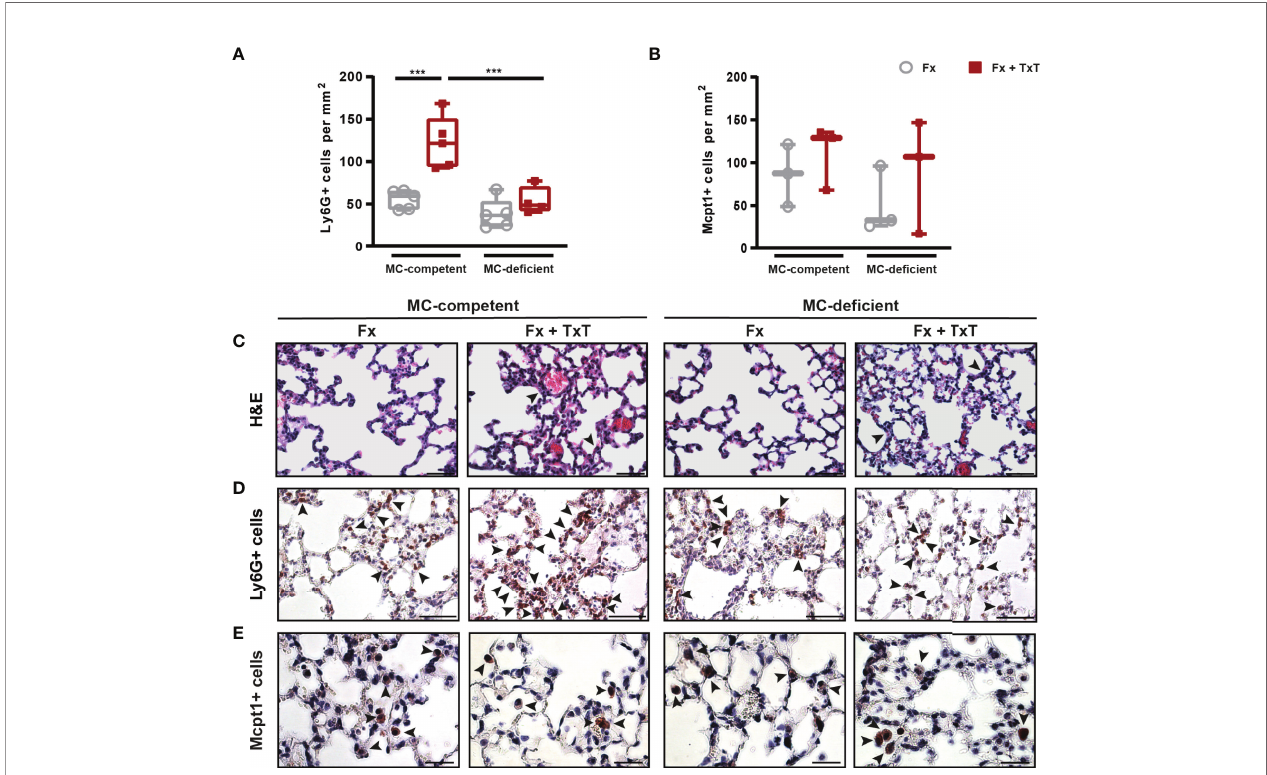
FIGURE 4 | Pulmonary in fl ammation in mast cell (MC)-competent and MC-de fi cient mice 3 and 6 h after isolated fracture (Fx) and combined fracture and thoracic trauma (Fx+TxT). (A) Number of Ly6G+ cells (neutrophils) in the lung of MC-competent and MC-de fi cient mice after 3 h. (B) Number of Mcpt1+ cells (mucosal mast cells) in the lung of MC-competent and MC-de fi cient mice after 6 h. (C) Representative images of hematoxylin and eosin (H&E) stained lungs of MC-competent and MC-de fi cient mice. Arrowheads indicate wall thickening. Scale bar = 50 µm. (D) Representative images of lungs stained for neutrophils (Ly6G+). Arrowheads indicate positively stained neutrophils. Scale bar = 50 µm. (E) Representative images of lungs stained for mucosal mast cells in MC-competent and MC-de fi cient mice after 6 h. Arrowheads indicate positively stained mast cells (Mcpt-1+). Scale bar = 25µm. Gray boxes represent Fx mice, red boxes represent Fx + TxT mice. Data are shown as box-and-whisker plots (with median and interquartile range) from maximum to minimum, showing all data points. ***p<0.001. The p values were determined using one- way ANOVA with post hoc Fisher ’ s